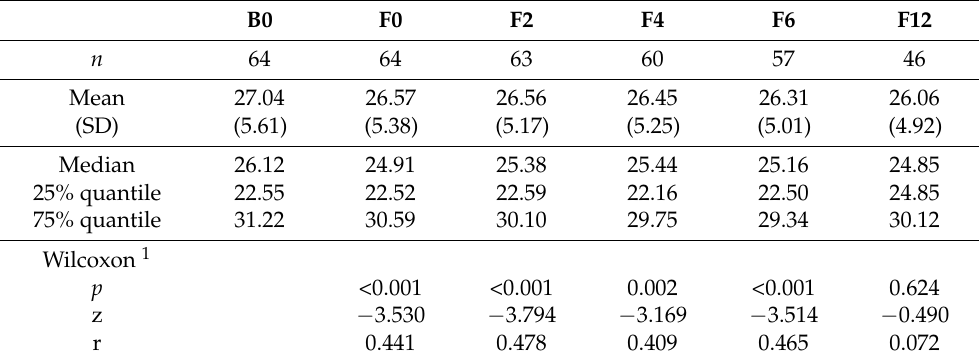
Table 5. Development of the BMI, using Wilcoxon signed-rank